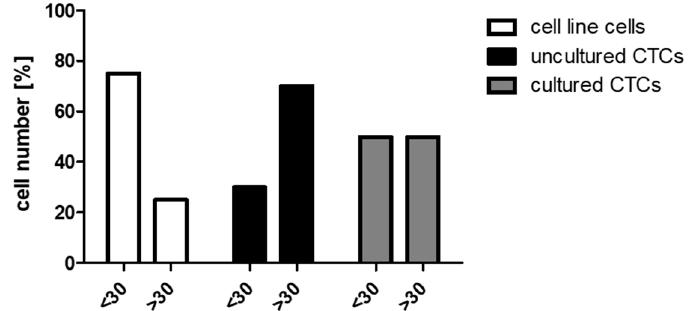
Figure 1. RNA quality of isolated single tumor cells. Signal intensities (Cq < 30: single cells with a Cq < 30 of ACTB and a Cq < 30 of KR19 , Cq > 30: single cells with a Cq > 30 of ACTB and / or KR19 ) of single cell line cells ( n = 8), uncultured CTCs ( n = 23), and cultured CTCs ( n = 10). CTCs: Circulating